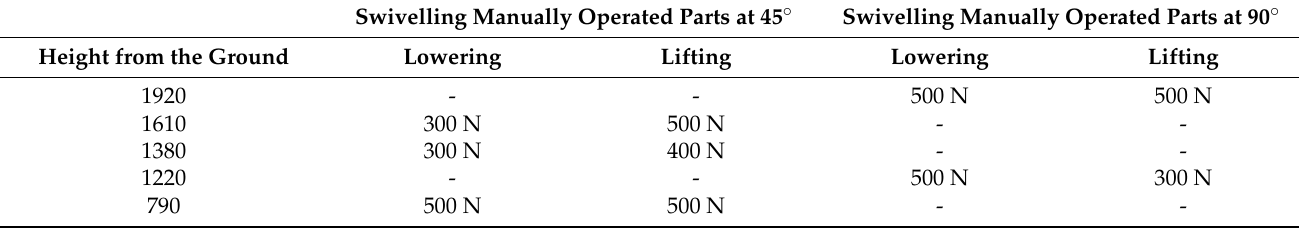
Swivelling Manually Operated Parts at 45 ◦